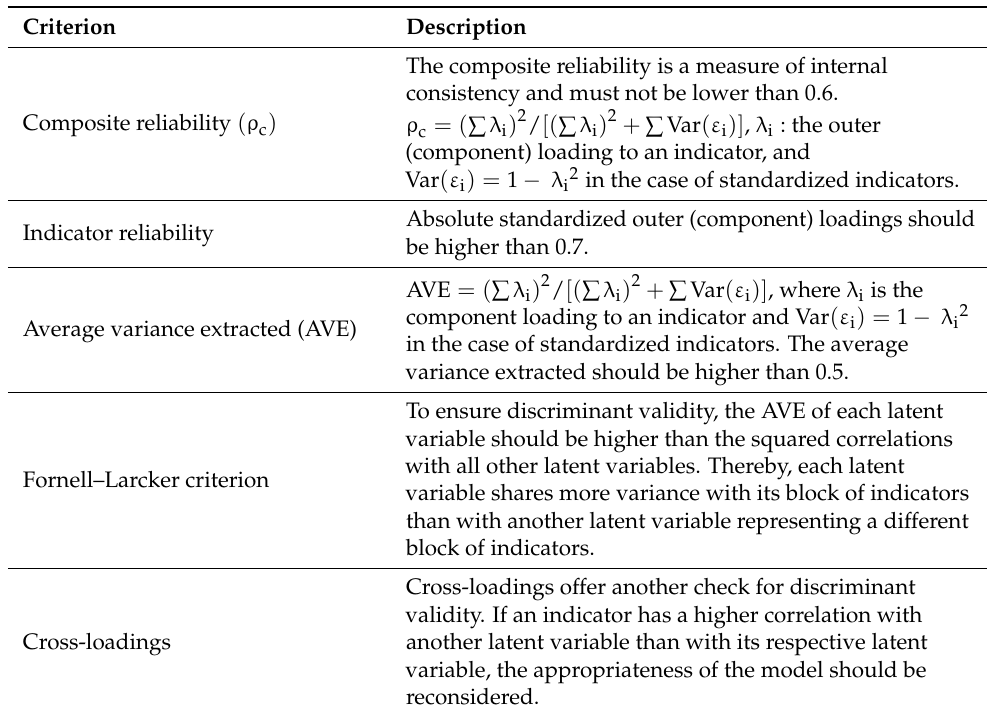
Table 4. Measurement model evaluation process